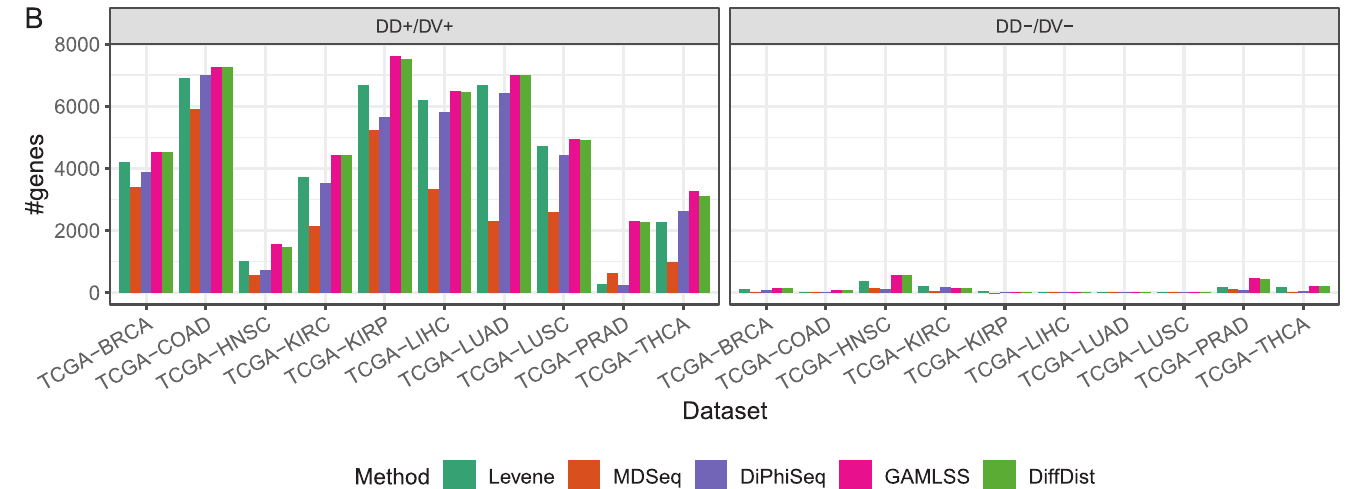
PLOS Computational Biology | https://doi.org/10.1371/journal.pcbi.1010342 March 9,